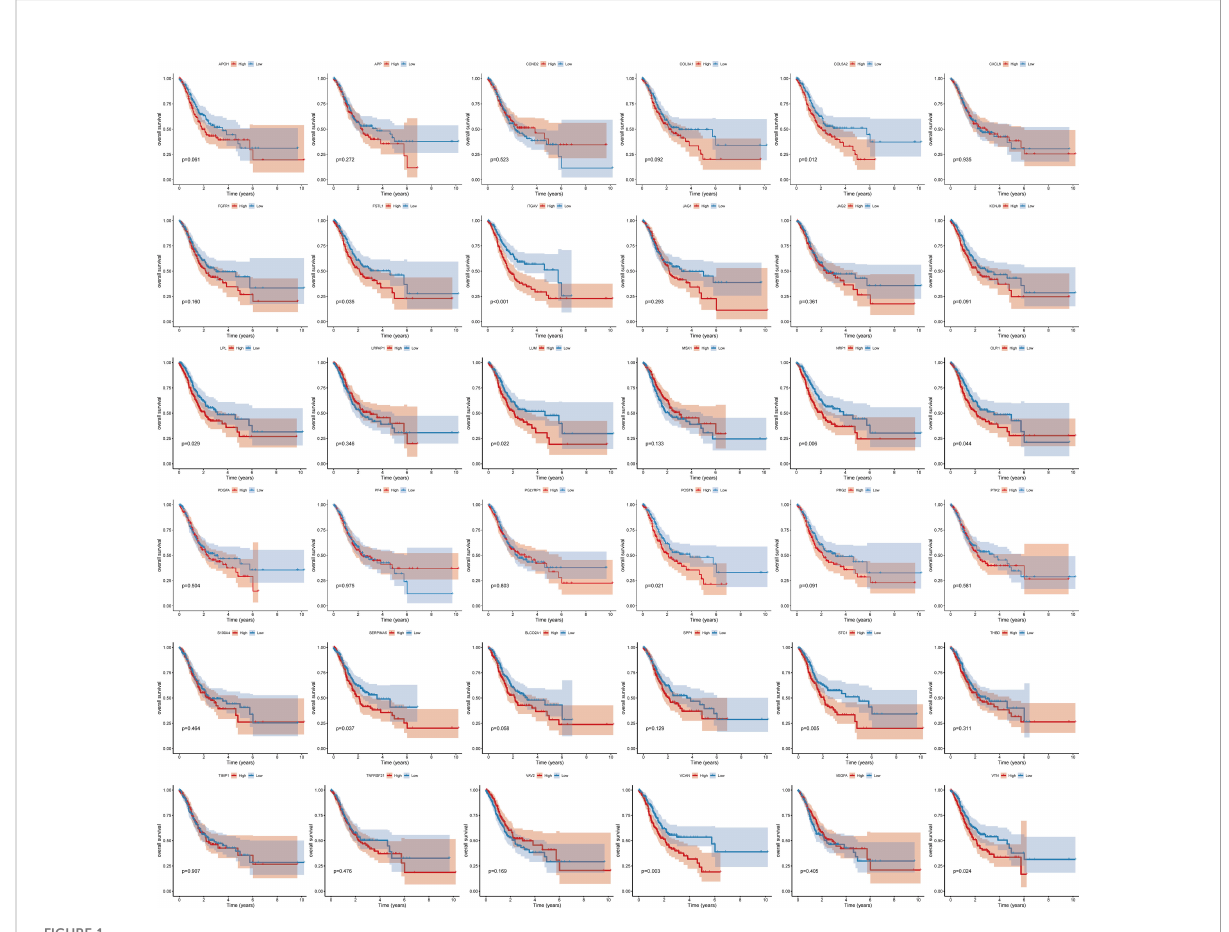
FIGURE 1 Survival curve of angiogenesis-related